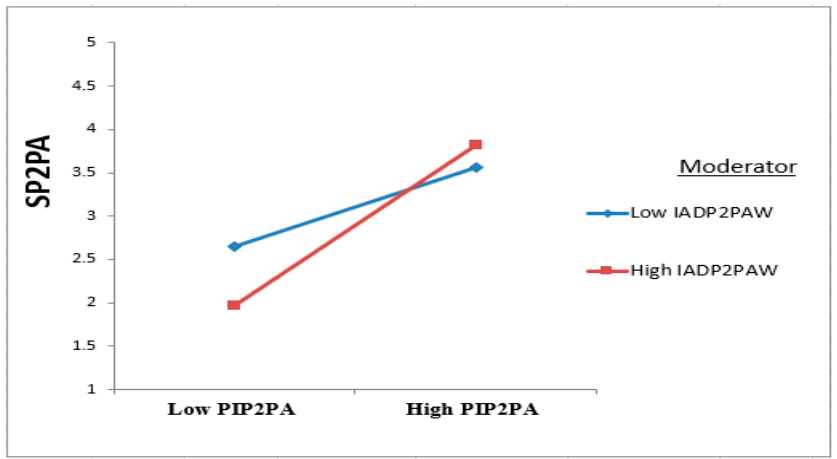
Figure 3. Interaction plot for the IADP2PAW moderation effect on PIP2PA towards SP2PA.